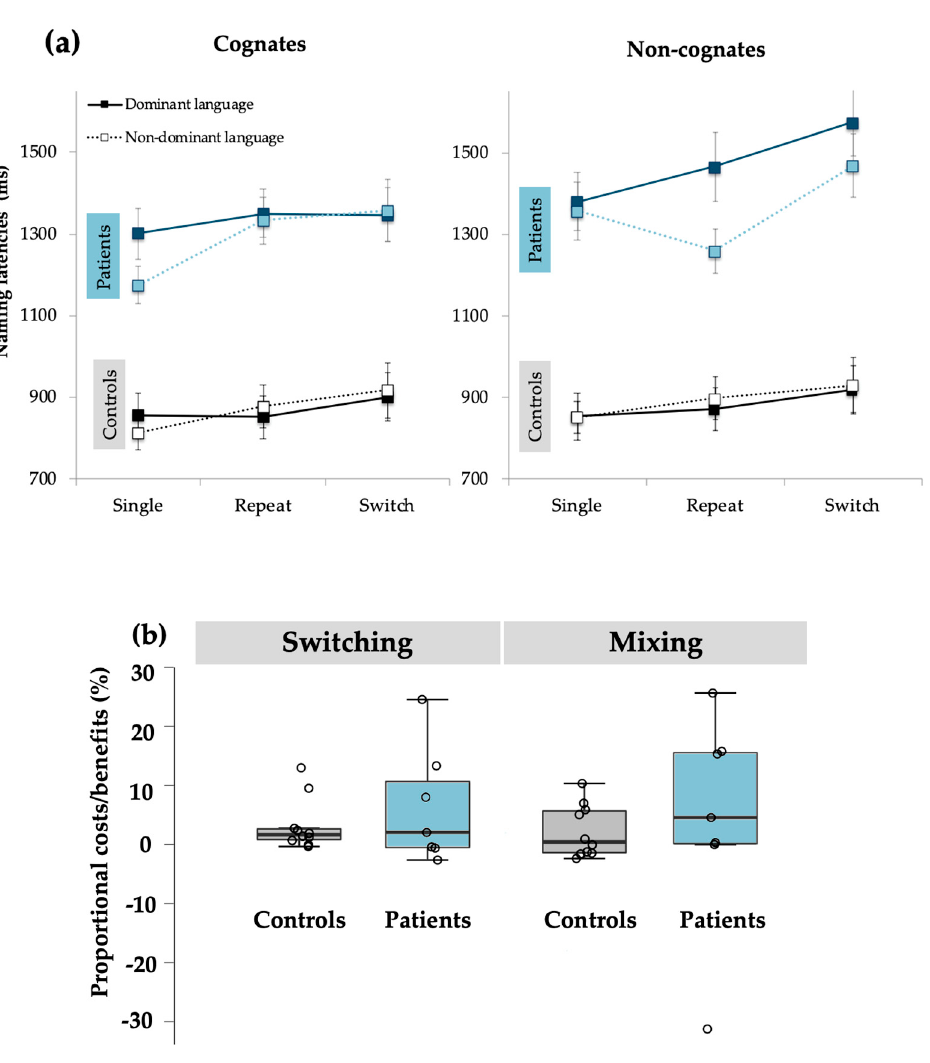
Figure 2. Performance of BWAs and controls on the voluntary language switching task: ( a ) Naming latencies for both experimental groups separated by Trial Type, Language, and Cognate Status. ( b ) Distribution of proportional switching and mixing effects for BWAs and controls.